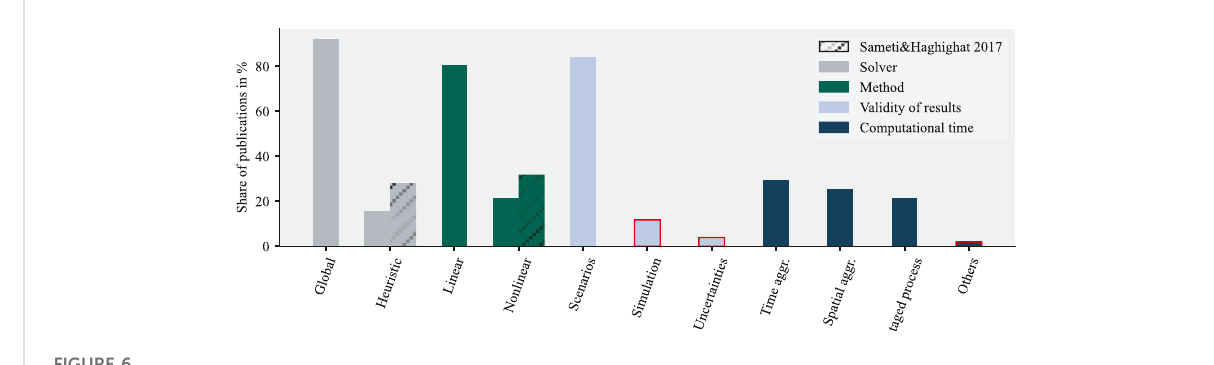
FIGURE 6 Literature distribution over the supercategories method, solver, computational time, and validity of results with comparison to (Sameti and Haghighat, 2017); low numbers of publications ( < 15%) are marked red as an indication of a potential research gap.